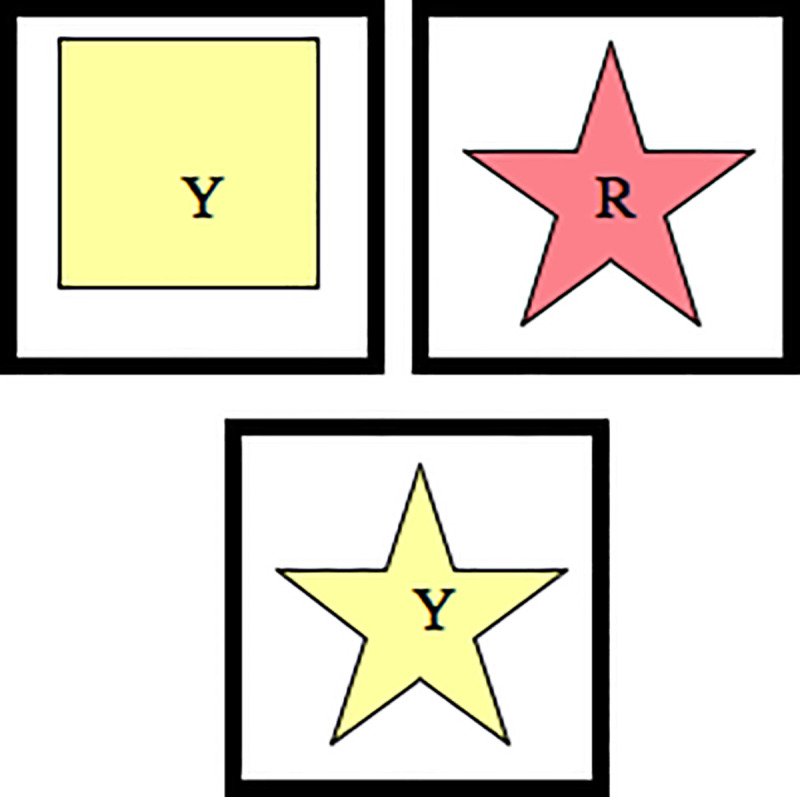
Example of two-target condition.The test card, a yellow star, is matched to the yellow square when the sorting rule is colour, and to the red star when the sorting rule is shape.